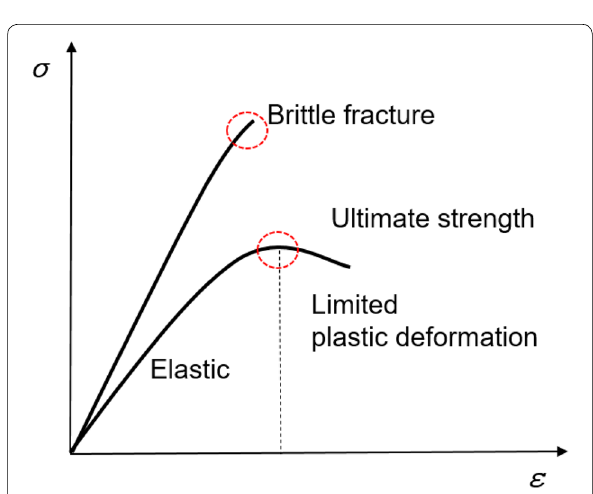
Fig. 11 Shape of the stress–strain curve in longitudinal and transverse